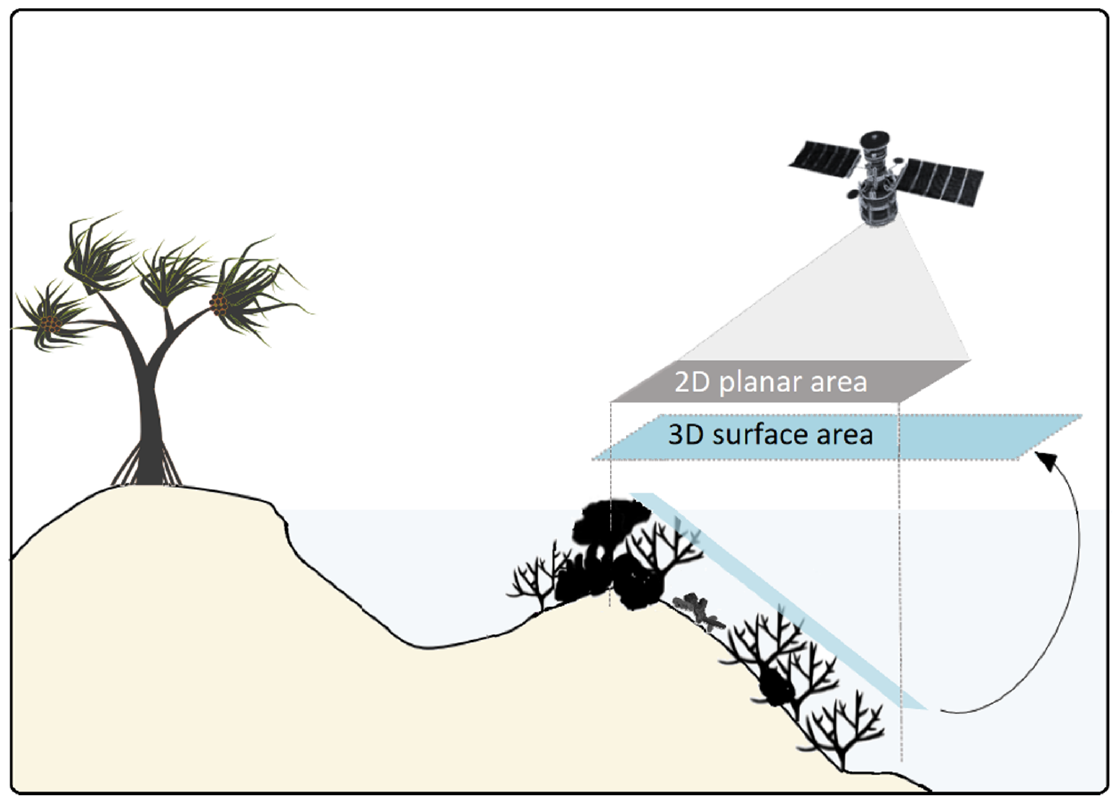
Figure 3. Conceptual diagram for calculation of 3D surface area based on 2D planar area (i.e., horizontal projected area) and the slope component. Example shown for the slope geomorphic zone. Graphics courtesy of the Integration and Application Network, University of Maryland Center for Environmental Science.